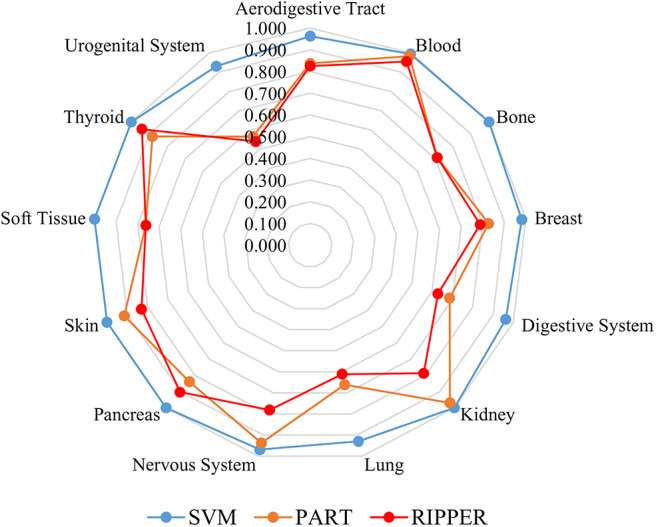
Radar chart to show the performance of the best SVM, PART, and RIPPER classifiers on 13 tissues based on the feature list yielded by MCFS.